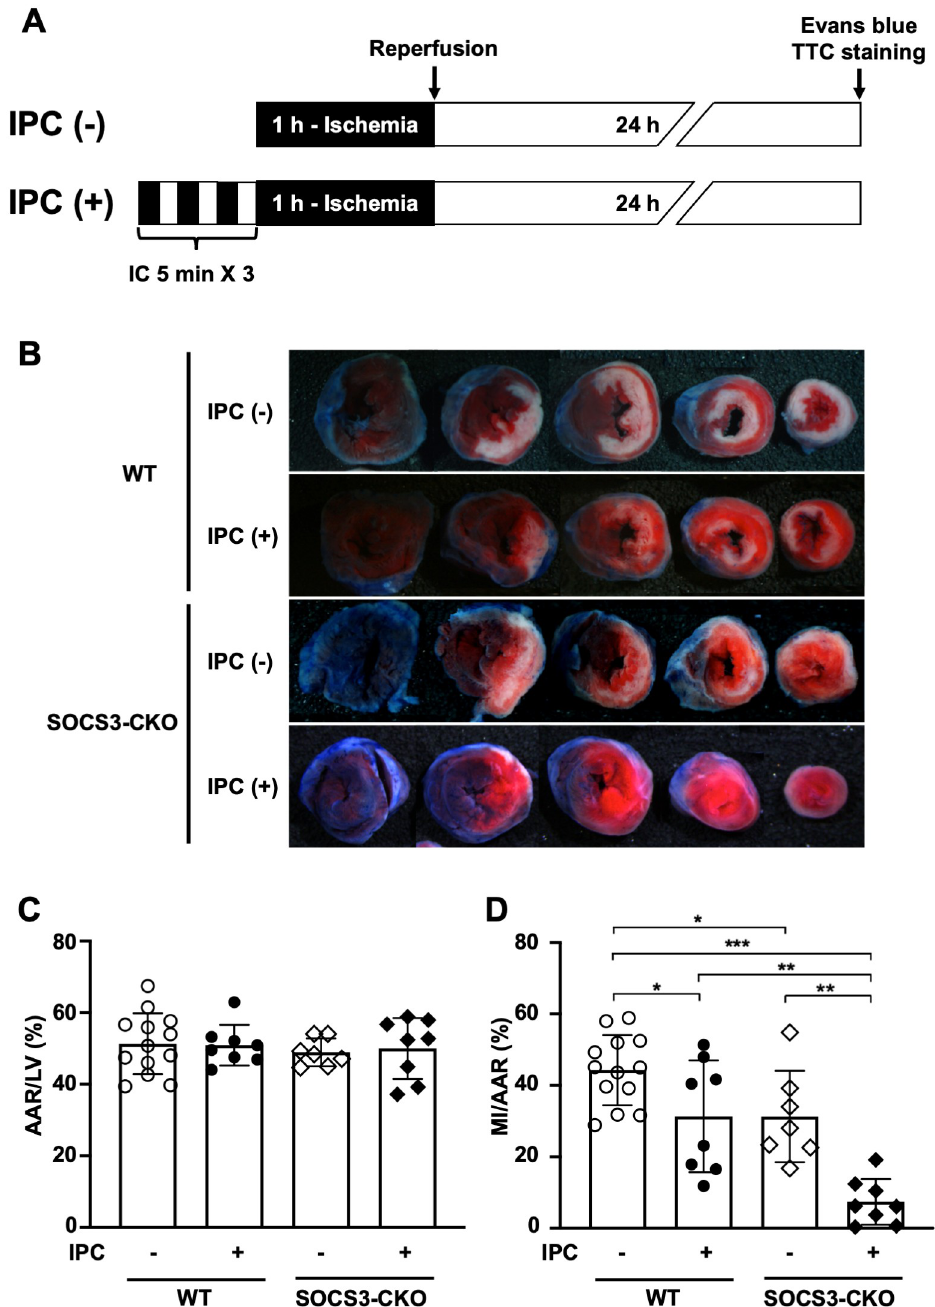
Fig 3. Substantial reduction of infarct size via ischemic preconditioning after I/R in SOCS3-CKO mice. ( A) Schematic illustration depicting the experimental protocol. IPC was performed with three cycles of 5-min ischemia and 5-min reperfusion. The LAD coronary artery was occluded for 1 h, and then reperfused for 24 h. ( B) Representative images of Evans blue and TTC staining in WT and SOCS3-CKO mice, with or without IPC, at 24 h after reperfusion (n = 7–13 per group). ( C) and (D) The infarct size of the LV was expressed as a percentage of the AAR of each group. Graphs show quantification of AAR/LV ( C ) and infarct area/AAR ( D ). � P < 0.05, �� P < 0.01, ��� P < 0.001 (Dunn’s test). I/R, ischemia reperfusion; IPC, ischemic preconditioning; LAD, left anterior descending; TTC, triphenyltetrazolium chloride; WT, wild-type; LV, left ventricle; AAR, area at risk.